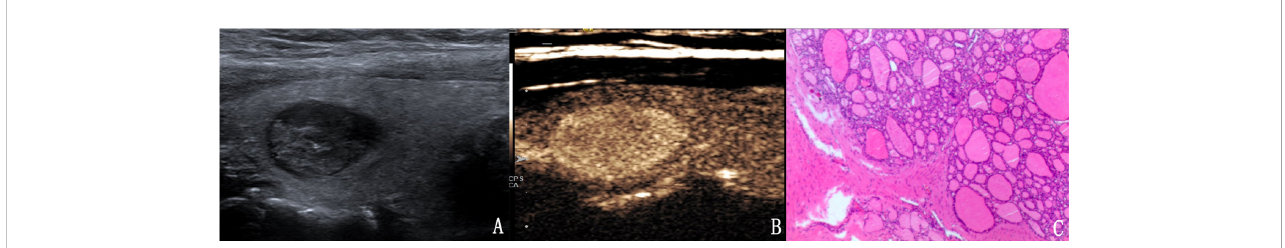
FIGURE 3 The case of a 31-year-old woman with a 15.1 × 10.1 × 9.8 mm solid hypo-echoic nodule in the right lobe of the thyroid. (A) Conventional ultrasound showed that the nodule had one malignant indicator (solid) and was classi fi ed as a TI-RADS score of 3. (B) Contrast-enhanced ultrasound detected high enhancement. The modi fi ed TI-RADS resulted in a score of 2 and indicated a benign nodule. (C) Pathology of the lesion showed an